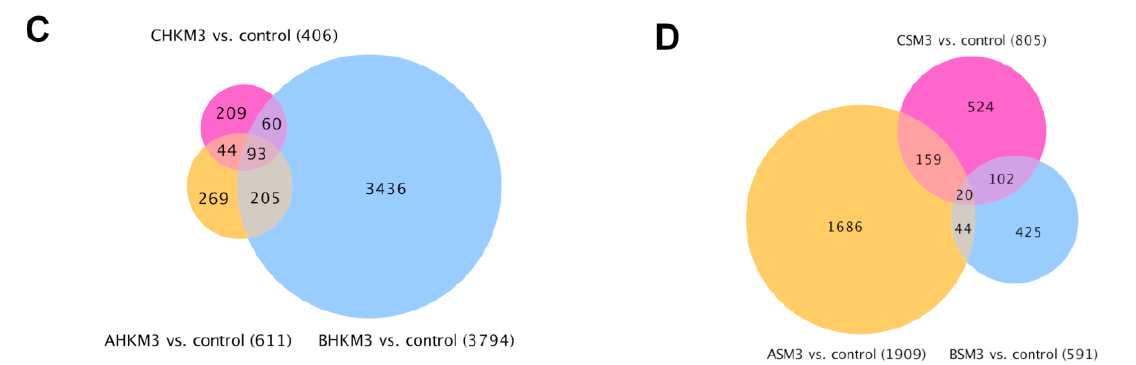
Figure 1. Transcriptome profiling expression of vaccinated Atlantic salmons. ( A ) Heatmaps showing expression values (TPM) in the head kidney and skin tissue. ( B ) Fold change count of up- and down-regulated contigs. The Y -axis was segmented for better data visualization. Venn diagram showing the distribution of contigs differentially expressed in head kidney ( C ) and skin ( D ) tissue. (Fold Change ≥ |4|; FDR = 0.05).